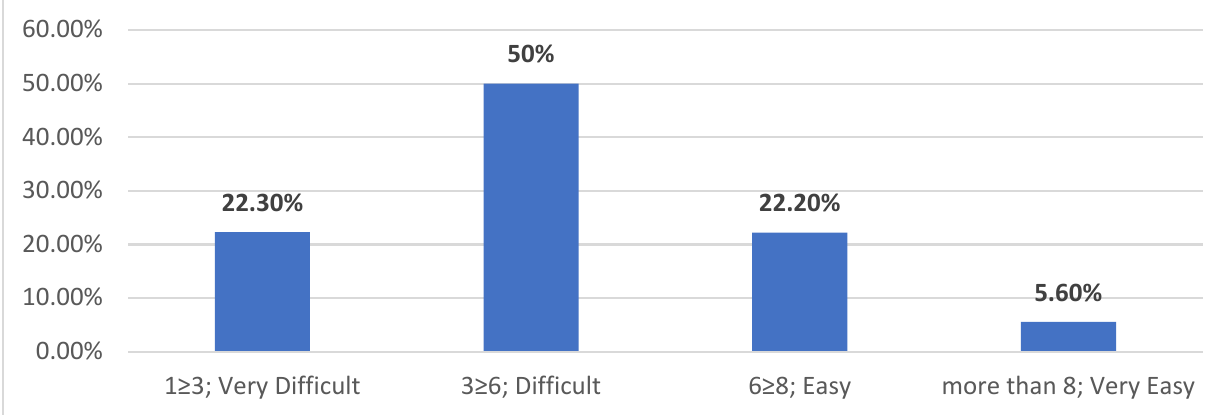
Figure 2. Ease of conducting business in Albania (N = 36). Source: (Authors’ own elaboration). In terms of the distribution among males and females in the business of the respon- dents, there seems to not be any dominant gender, considering that they are both nearly equal (Table 3). When questioned about ever feeling discriminated from the opposite gender entrepreneurs, the answers were equally distributed as 50/50. However, in general, there seems to be a higher ratio of females being discriminated by their fellow colleagues. Moreover, approximately 61% of the respondents admitted that employed females posi- tively affected their business performance, whereas the remaining respondents stated the opposite (Table